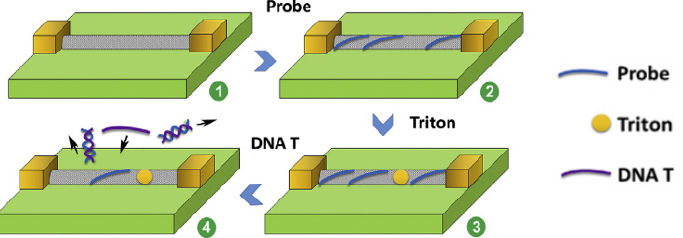
Figure 16. The construction and DNA sensing with the use of CNT-based chemiresistor. Adapted with permission from Fu et al. [113] (copyright © (2017), Elsevier).